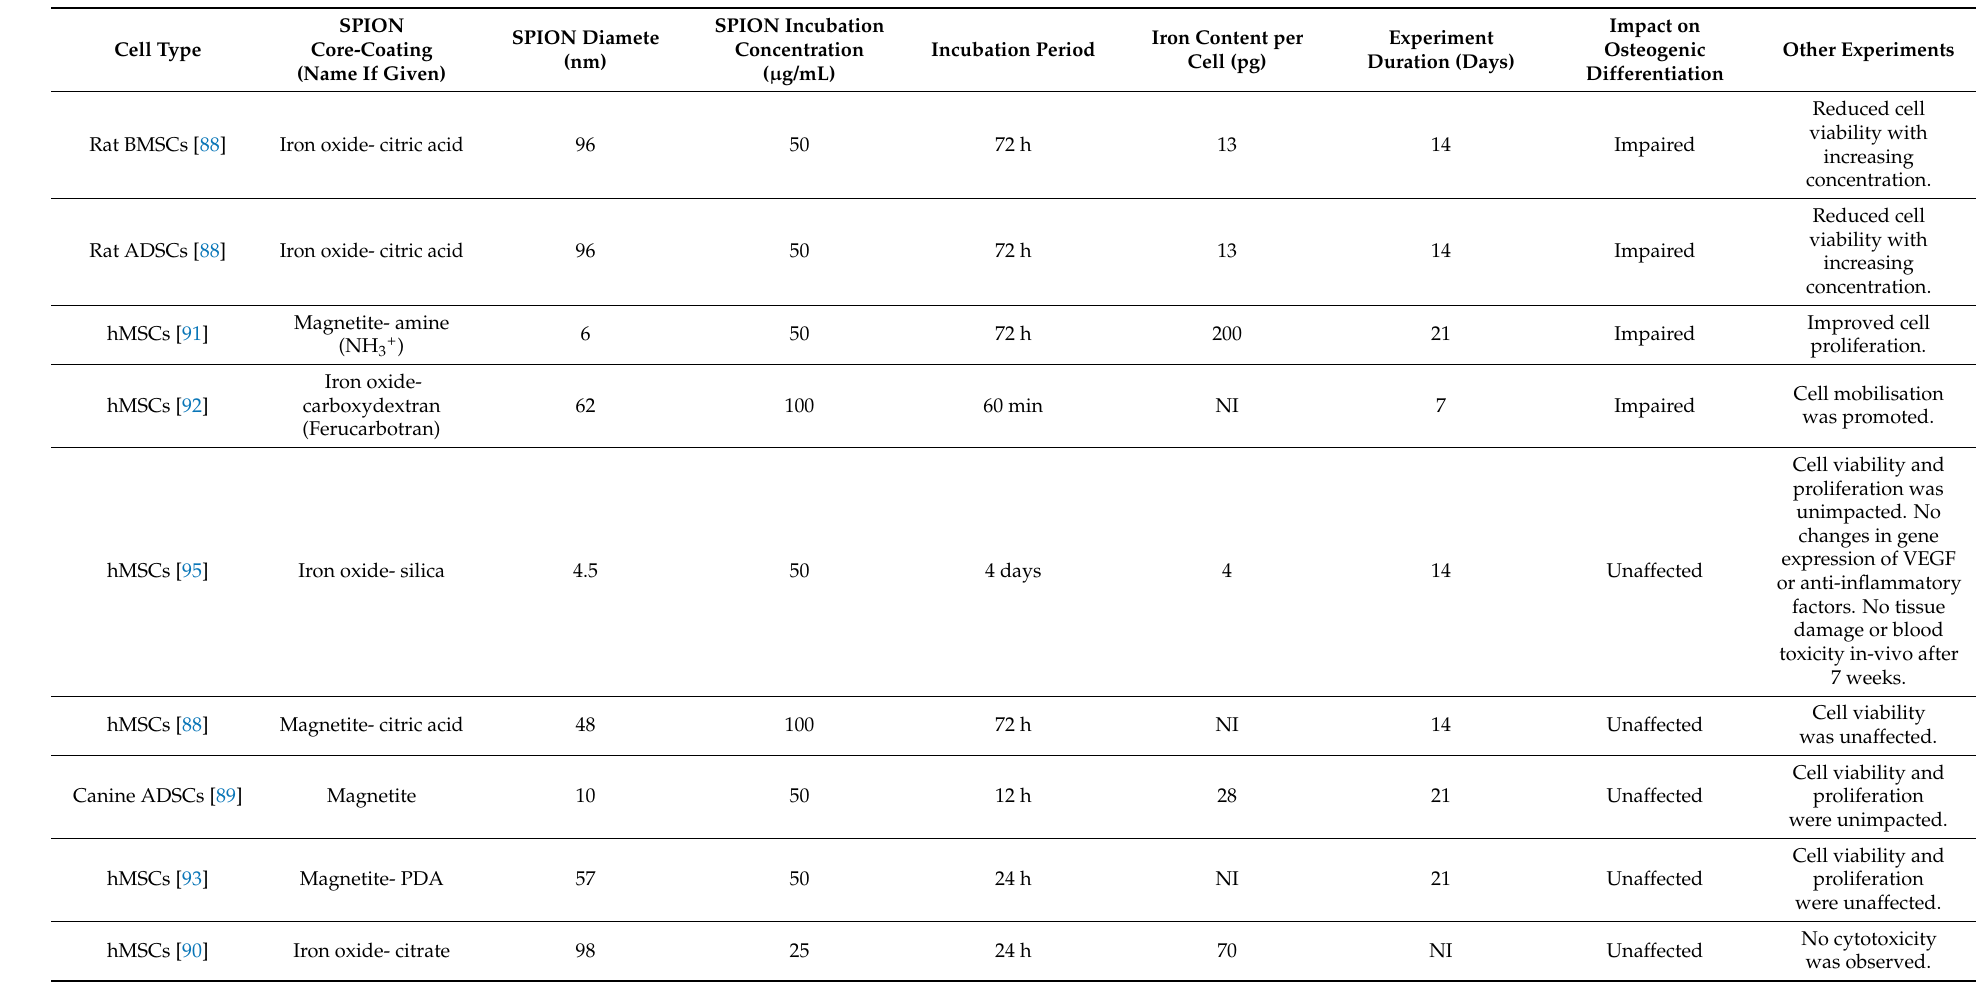
Table 2. A table summarising the various studies that investigated the impact of SPION dose on the osteogenic differentiation of stem